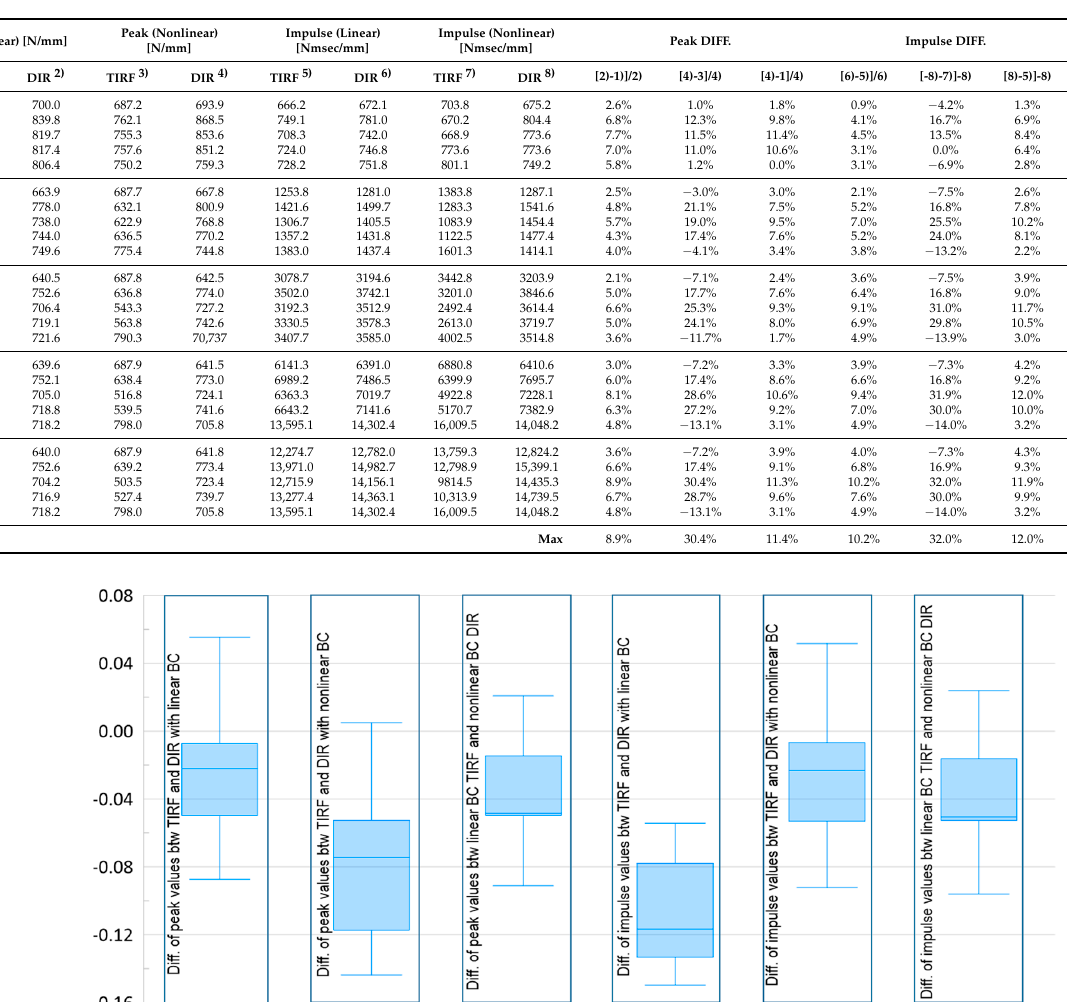
Table 7. Bending responses for LNG cargo containment boxes (Model 2).